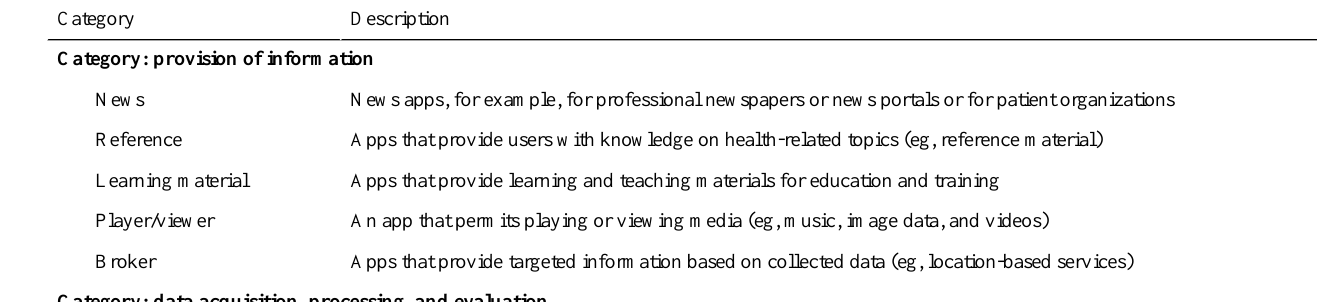
Table 2. Function-related types as defined in the CHARISMHA study, including their superordinate categories, which were used in our manual classification